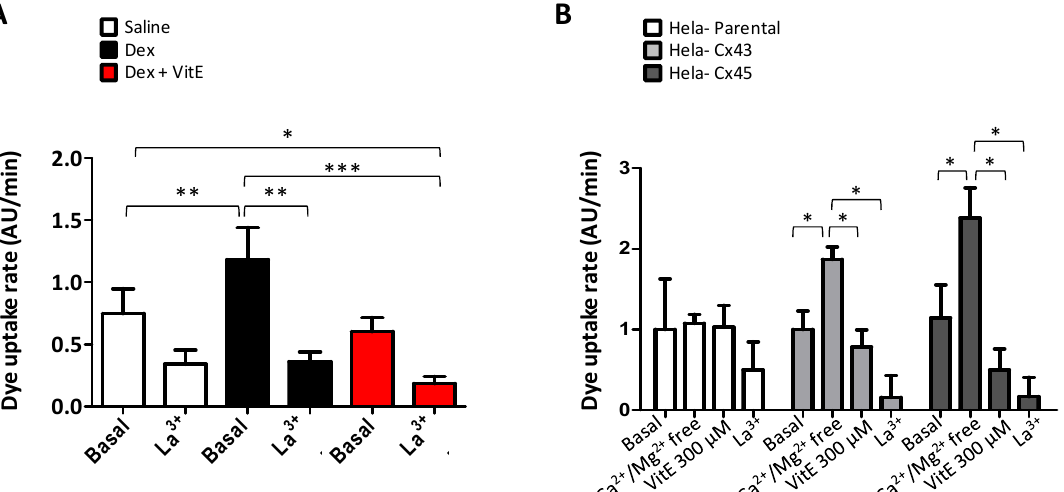
Figure 5. Vitamin E blocks the connexin hemichannel activity in skeltal myofibers of dexamethasone- treated mice and in transfected HeLa Cx43EGF cells. The activity of connexin hemichannels (Cx HCs) was measured using the dye uptake assays. ( A ) Etd + uptake rate in isolated myofibers from the flexor digitorum brevis muscle of mice treated or not treated with (Dex, 10 mg / kg / day) or Dex + VitE ( n = 4). ( B ) Etd + uptake rate of HeLa-Parental, HeLa Cx43 and HeLa Cx45 cells measured under control conditions (basal) and after exposure to (Ca 2 + / Mg 2 + free) Krebs solution, and then treated with 300 µ M VitE and lanthanum ion (La 3 + ), a Cx HC blocker. Notice the enhanced dye uptake after incubation in Ca 2 + / Mg 2 + -free solution that induces opening of Cx HCs. n = 4 independent experiments for each cell line. * p < 0.05; ** p < 0.01; *** p < 0.001; as indicated with brackets.